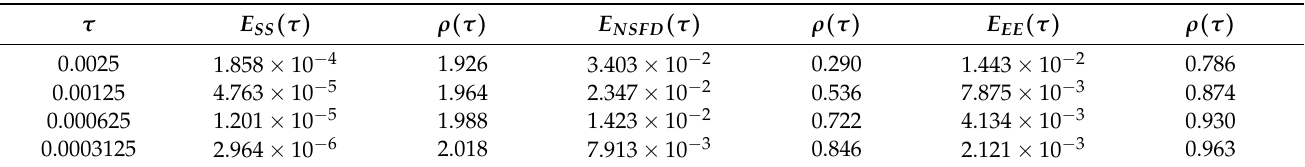
Table 7. Errors E ( τ ) and experimental convergence rates ρ ( τ ) for the discrete solution of the splitting scheme (29)–(31) and the NSFD and classical explicit Euler schemes from [25] for a sequence of time steps τ